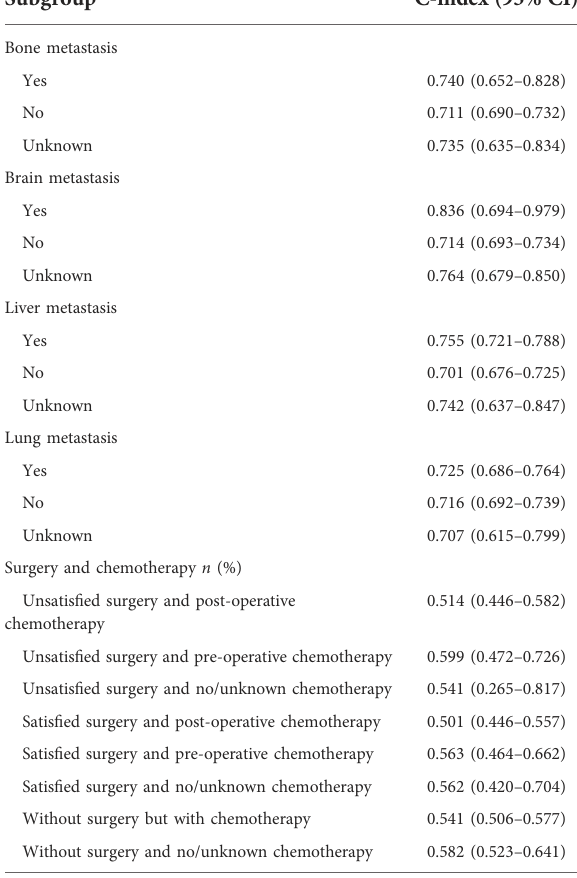
TABLE 6 The predictive values for 2-year overall survival in the model in different subgroups.